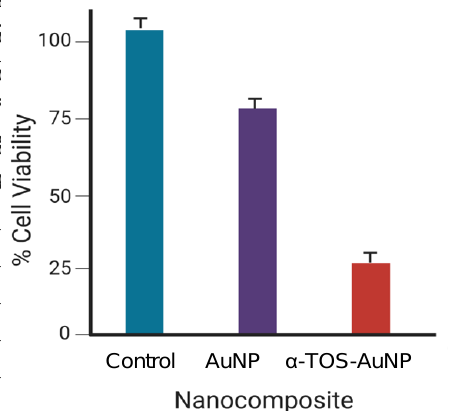
Figure 4. Cell viability graph of α -TOS-AuNP-treated cells compared to unfunctionalized AuNPs using a concentration of 50 μM (Created with BioRender.com, accessed 6 December 2022).